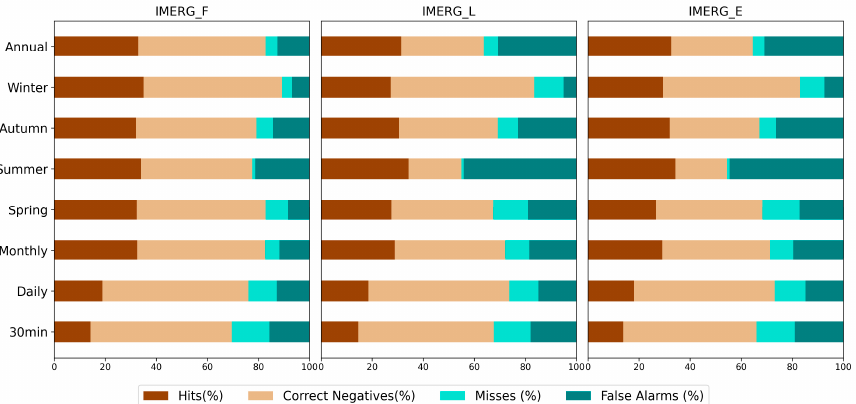
Figure 6. Fraction of events detected as hits, false alarms, misses and correct negatives for the three IMERG products at different time scales. The thresholds selected for each time scale coincide with the mean of the observations at that scale: Half-hourly (1.4 mm), Daily (8.6 mm), Monthly (52.8 mm), Spring (185.8 mm), Summer (118.8 mm), Autumn (203.9 mm), Winter (126.7 mm) and Annual (623.5